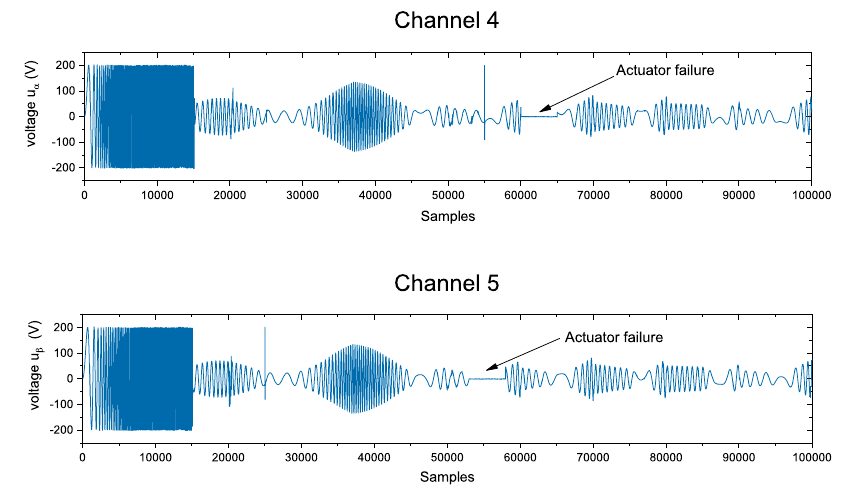
Figure 10. Actuator channel data set from the induction motor. The ROC curves of the four neural networks for different channels are shown in Figures 11–15. The CA and average time that each neural network takes to classify a sample are shown in Table 4. The different dimensions of the delayed vector used are presented. CA indicates the accuracy obtained. The area under the curve (AUC) of the ROC curve is given. Figure 16 shows the confusion matrix of all neural networks for Channel 3, the more complex Channel, using a 10-dimensional delay vector. Then, Figures 17 and 18 show the confusion matrix for Channels 4 and 5, respectively, using a 10-dimensional delay vector.